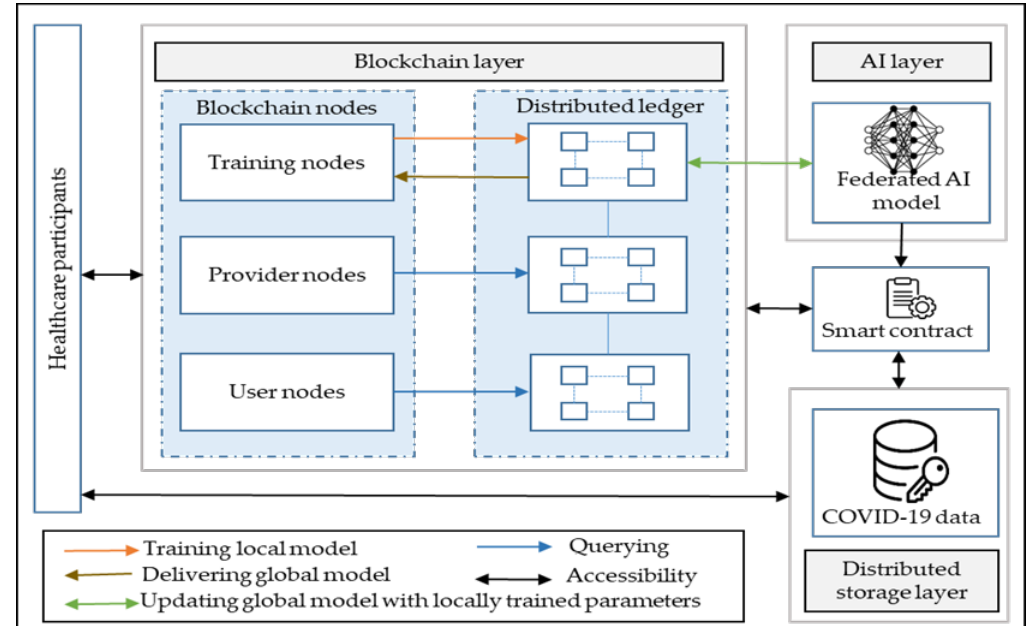
Figure 3. Schematic representation of the envisioned patient-centric framework using blockchain and AI technologies.